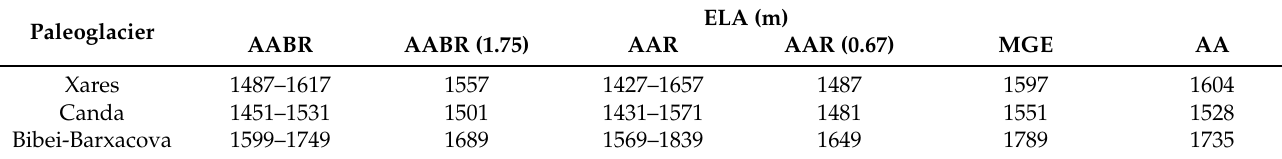
Table 5. General information about ELA estimation in each